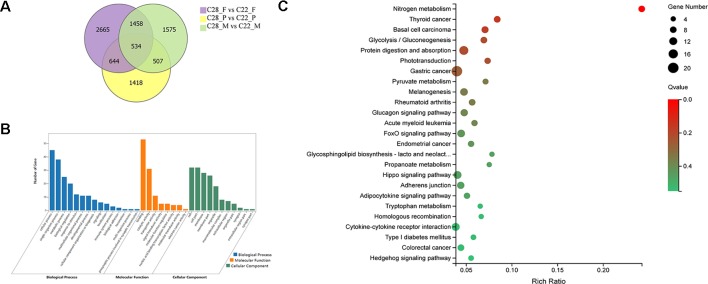
Analysis of DEGs in females, males, and pseudomales between high temperature and normal temperature. (A) Number of DEGs between high temperature and normal temperature shown by Venn diagram. (B) GO classifications of 534 DEGs in females, males and pseudomales between high temperature and normal temperature. (C) Enriched KEGG pathways of the 534 DEGs (p < 0.05).